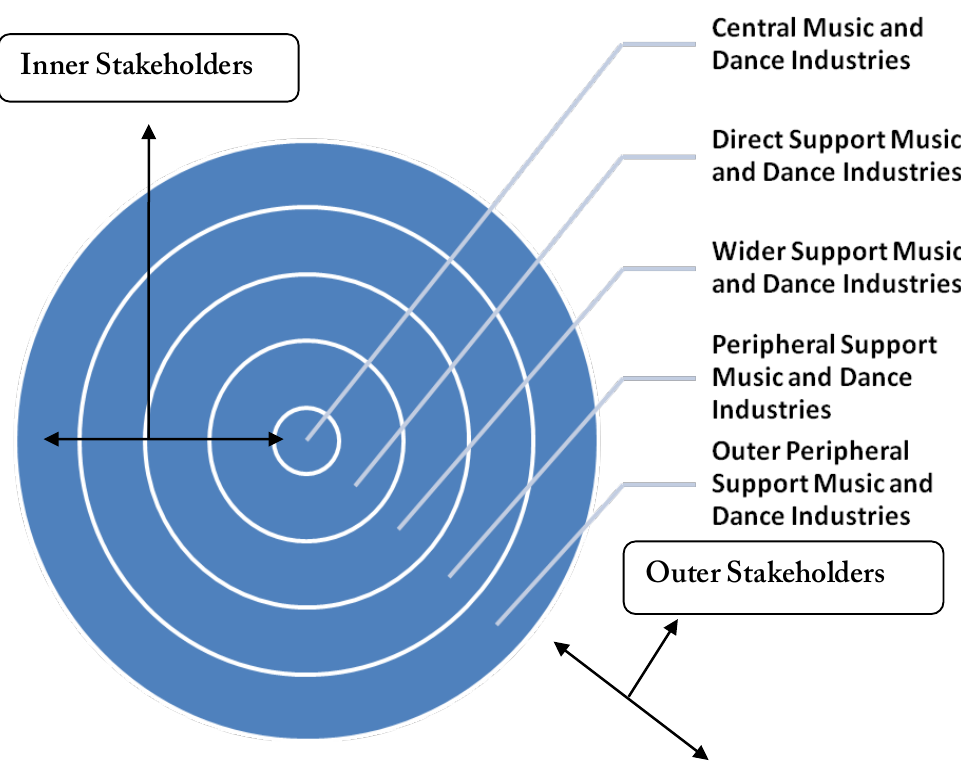
Figure 2: Structural Model of Indian Music and Dance Industries (IMDI) Proposals for